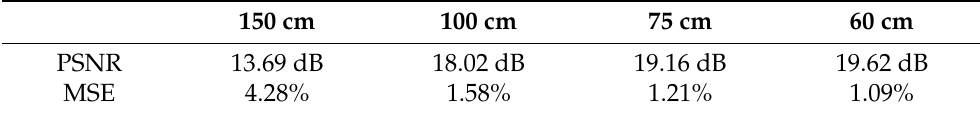
Table 3. Peak signal-to-noise ratio and mean square errors of the reconstructions in Figure